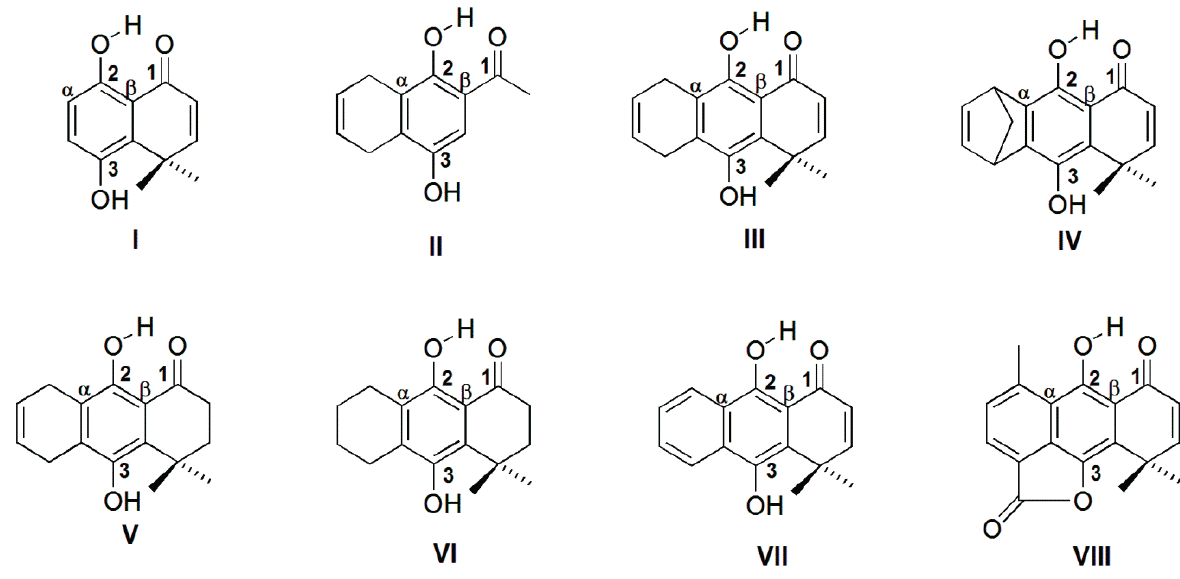
Figure 1. Structure of compounds studied in this